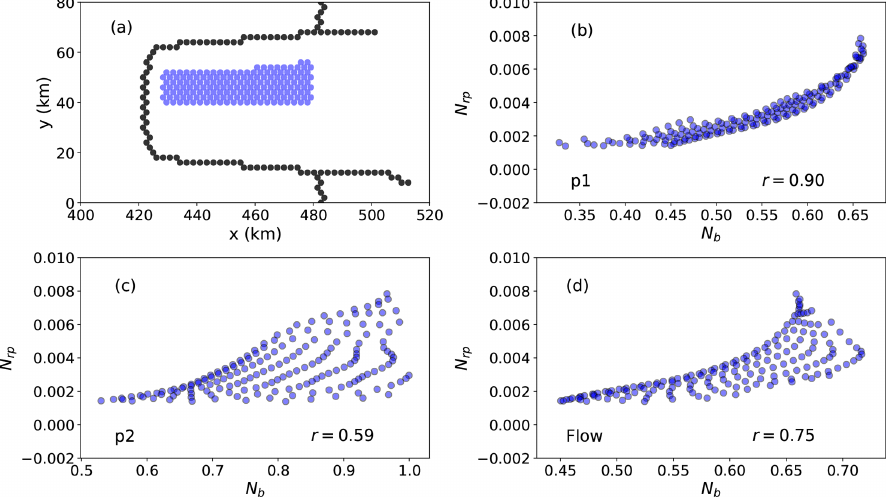
Figure 4. (a) Blue dots represent the locations of all perturbation points analyzed (168) for the N rp : N b linear-regression analysis based on the filtering criteria discussed in Sect. 4.1. Black dots indicate grid cells located along the grounding line. (b–d) Modeled N rp versus buttressing number N b calculated along (b) n p1 , (c) n p2 , and (d) n f . The correlation coefficient for each modeled N rp versus N b is given by r